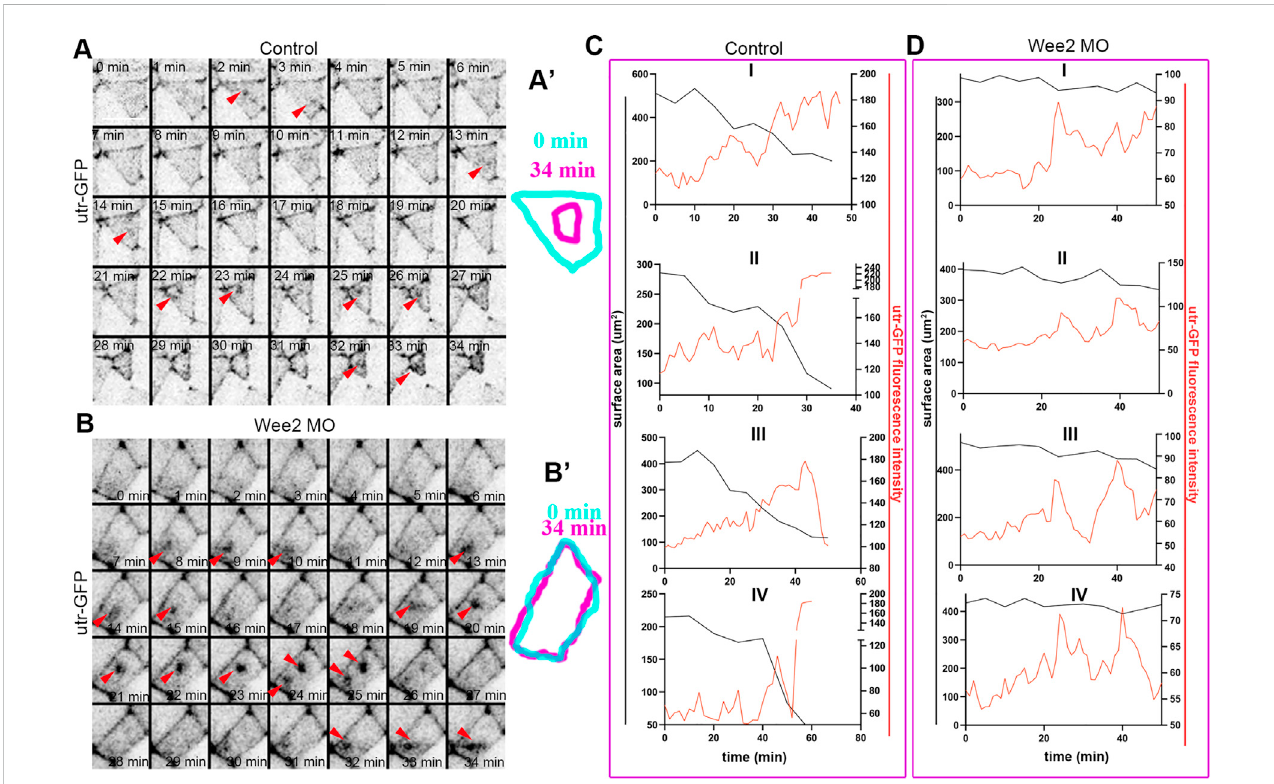
FIGURE 6 Somitic mesoderm morphogenesis affects the ratchetting of contraction pulses during apical constriction. (A) Stills from a time lapse recording of a controlneuroepithelialcellduringapicalconstriction.Redarrowheads:pulsedmedioapicalactinaccumulation.Scalebar:20 μ m. (A ’ ) Outlineoftheapicalcell surface area at 0 and 34 min showing reduction of apical cell surface area. (B) Stills from a time lapse recording of a neuroepithelial cell overlying Wee2morphantsomiticmesodermduringapicalconstriction.Redarrowheads:pulsedmedioapicalactinaccumulation.Scalebar:20 μ m. (B ’ ) Outlineof the apical cell surface area at 0min and 34 min showing defective reduction of apical cell surface area. (C,D) Quanti fi cation of medioapical actin intensity and apical cell surface area over time. (C) 4 control neuroepithelial cells. (D) 4 neuroepithelial cells overlying morphant somitic mesoderm. Medioapical actin accumulation (red line) is followed by reduction of the cell surface area (black line) in control cells. The cell surface area is not reduced upon apical F-actin accumulation in neuroepithelial cells overlying morphant somitic